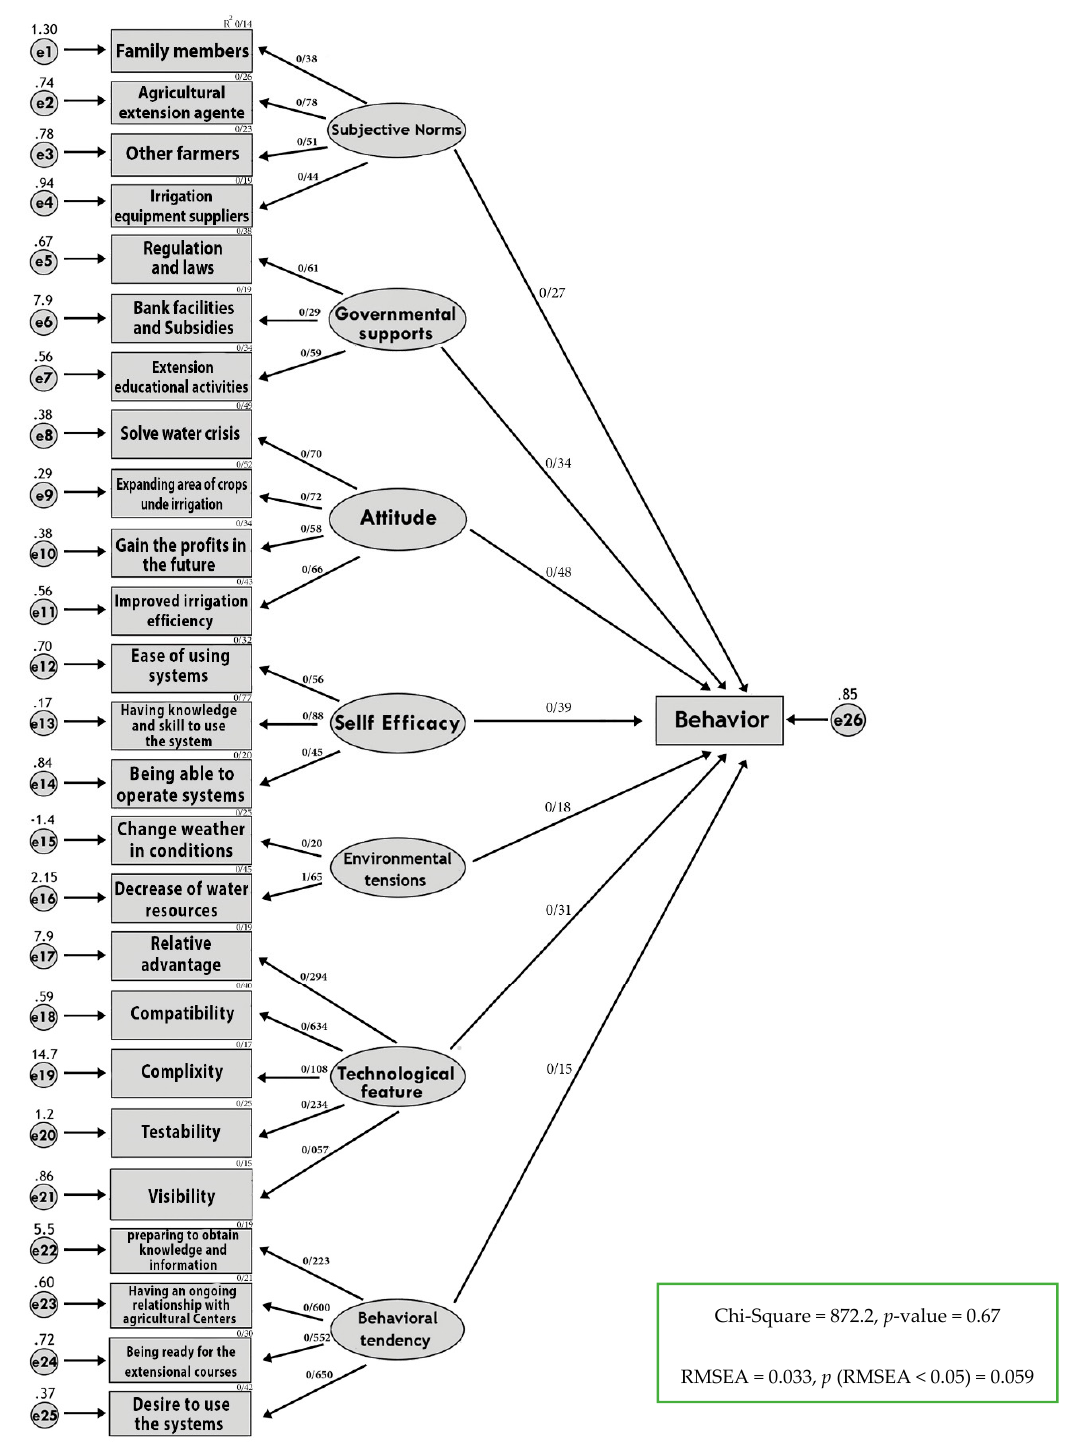
Figure 2. Final model of the behavior of using PISs of farmers.